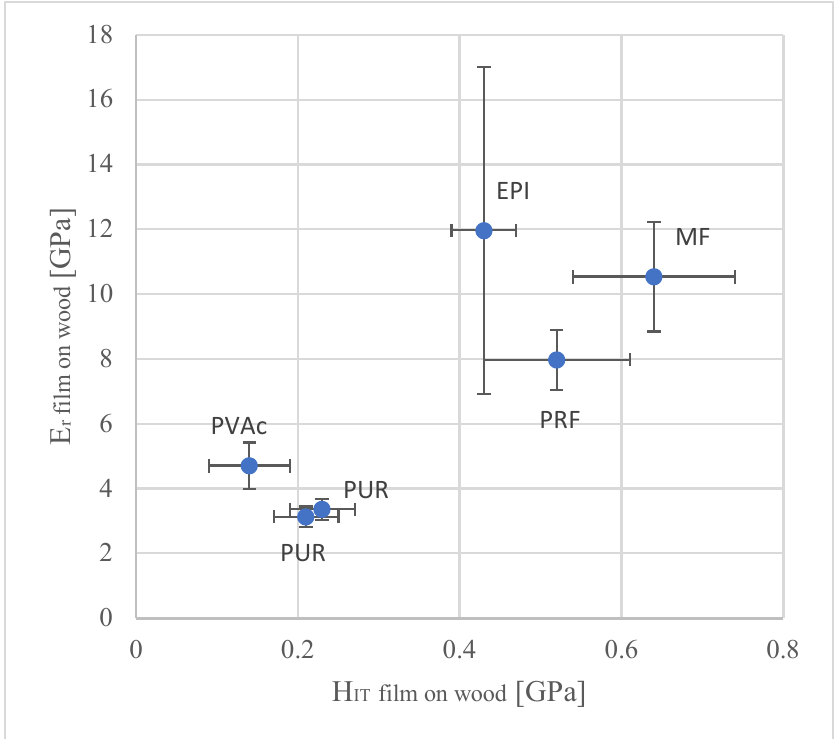
Figure 6. Comparison of the elastic modulus from the nanoindentation of the pure polymer films and polymers in the adhesive on the wood (error bars correspond to the standard deviation).